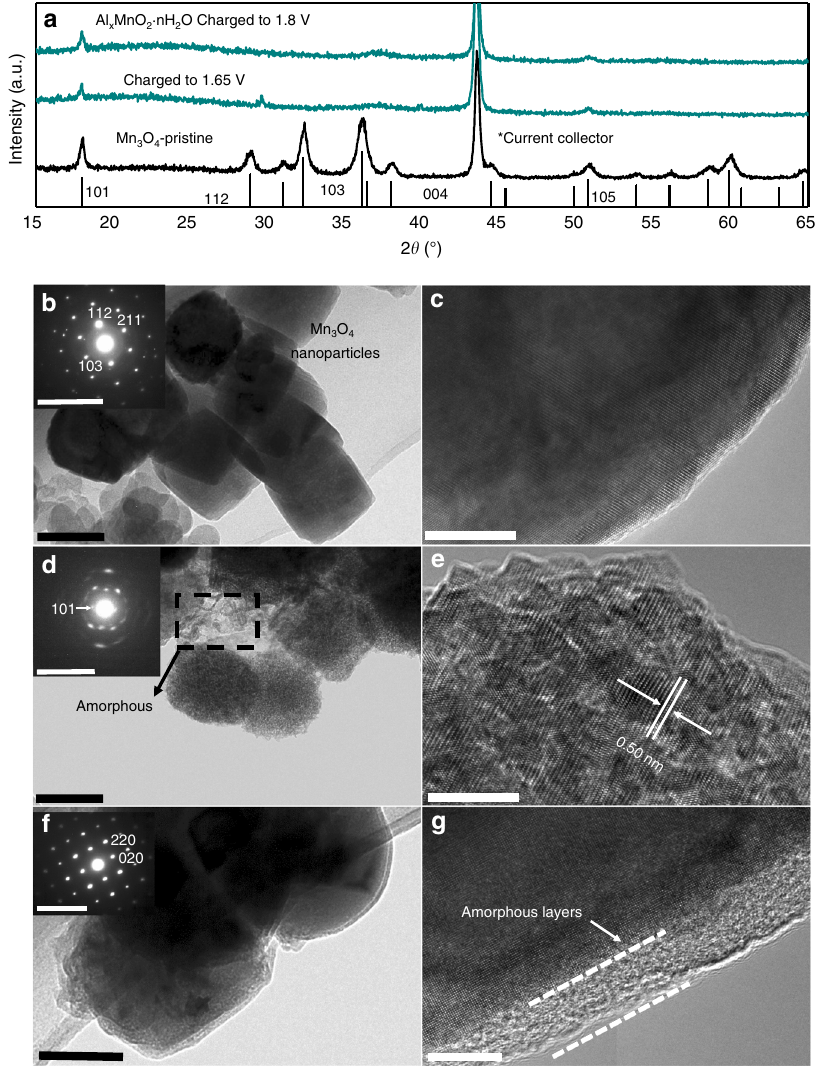
Fig. 2 Structure characterization of Al x MnO 2 · n H 2 O. a XRD patterns of Mn 3 O 4 and Al x MnO 2 · n H 2 O. b , c TEM image of the pristine Mn 3 O 4 , inset: SAED spectra. d , e TEM image of Al x MnO 2 · n H 2 O, inset: SAED spectra. f , g TEM image of Mn 3 O 4 after discharge, inset: SAED spectra. Scale bar: 100 nm for b , d , f ; 10 nm for c , e , g ; 10 1/nm for inset in b , d ,